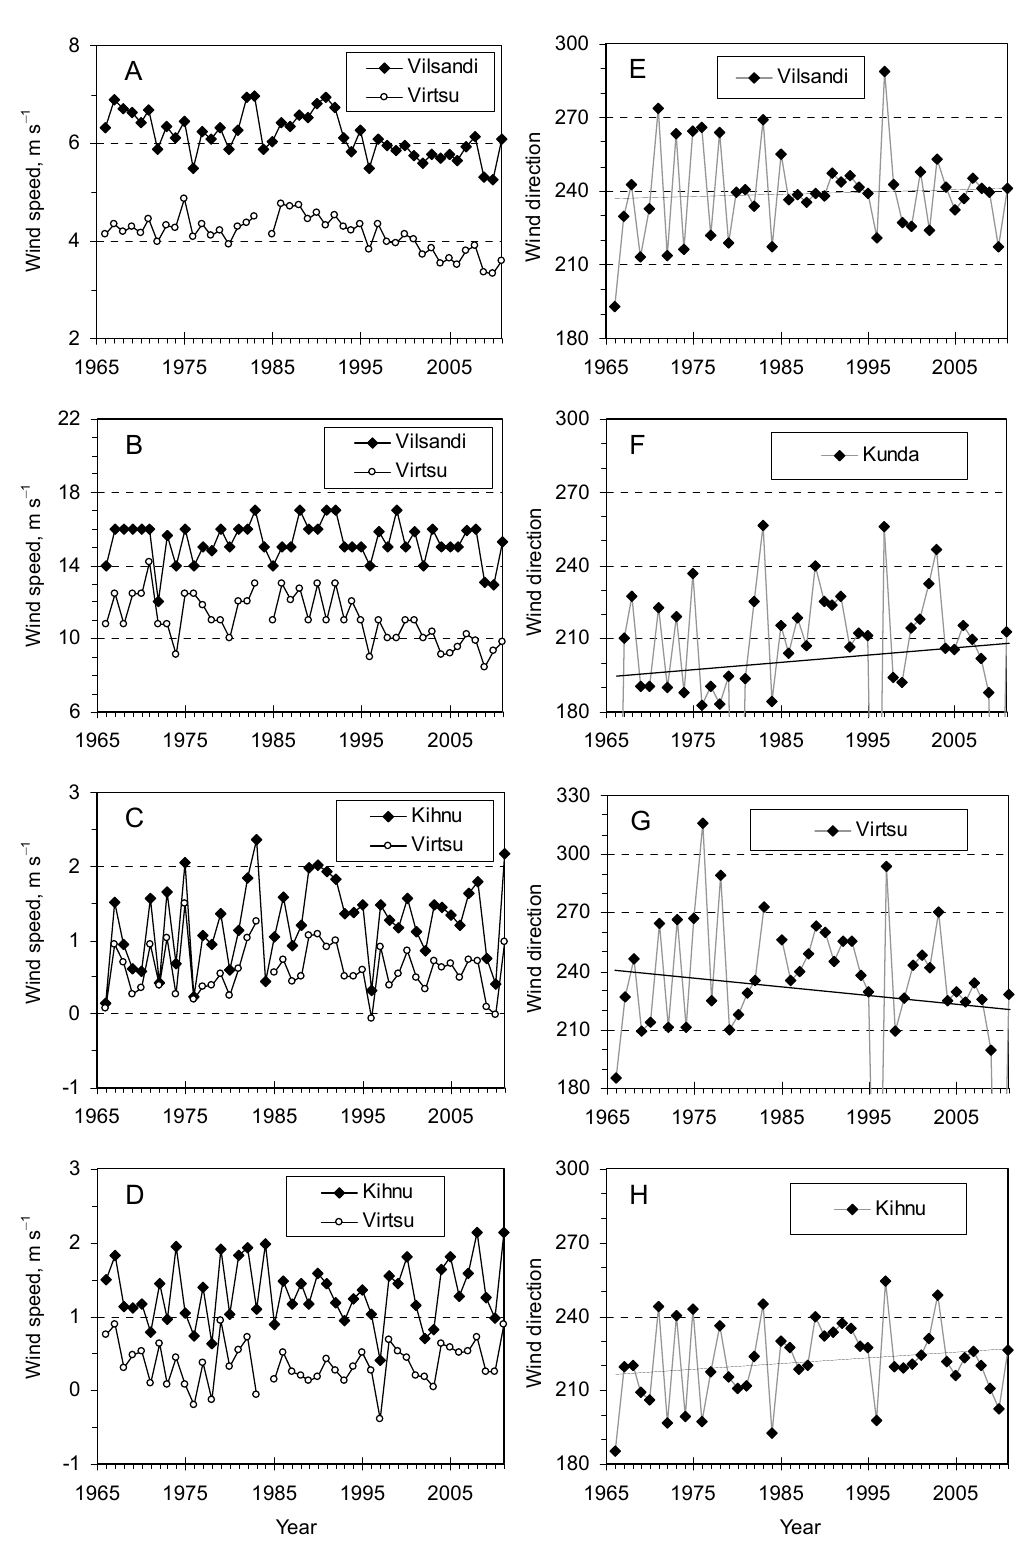
Fig. 7. Annual average (A) and 90%-ile (B) of the wind speed, annual mean zonal ( u ) (C) and meridional ( v ) wind component (D), and annual resulting wind direction calculated from the wind velocity components (E, F, G,